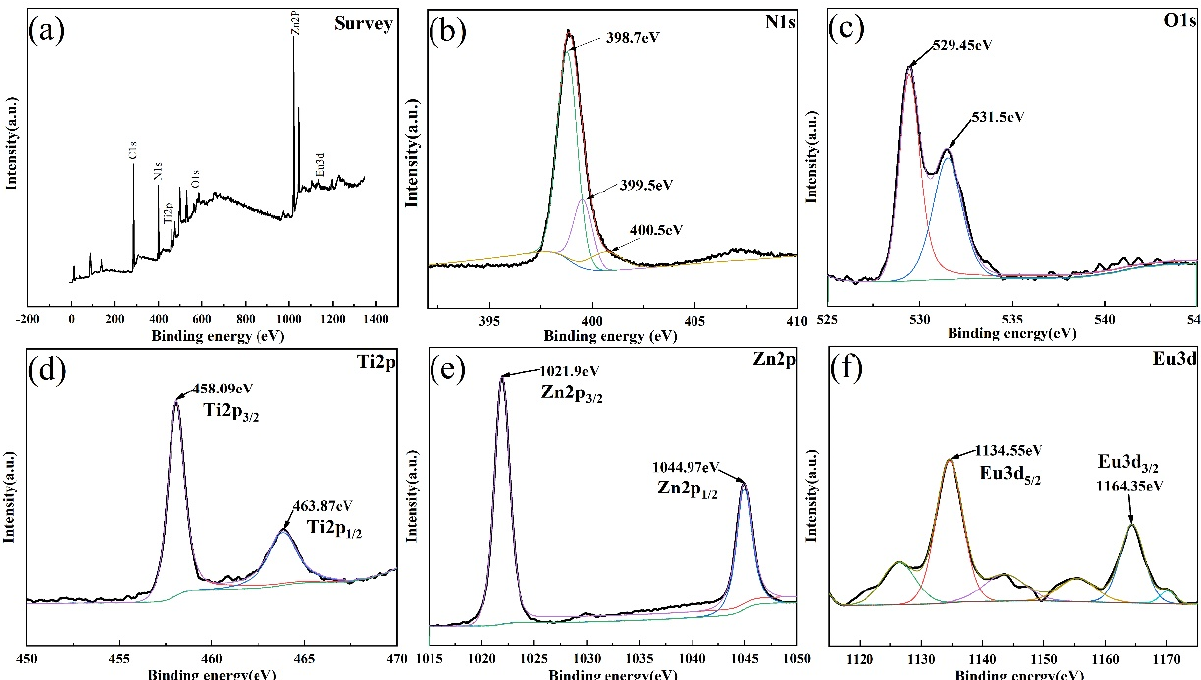
Figure 4. ( a ) XPS survey spectrum of ZIF-8(Eu)@Mc-TiO 2 . ( b – f ) N 1s, O 1s, Ti 2p, Zn 2p, Eu 3d, XPS spectrum of ZIF-8(Eu)@Mc-TiO 2 .